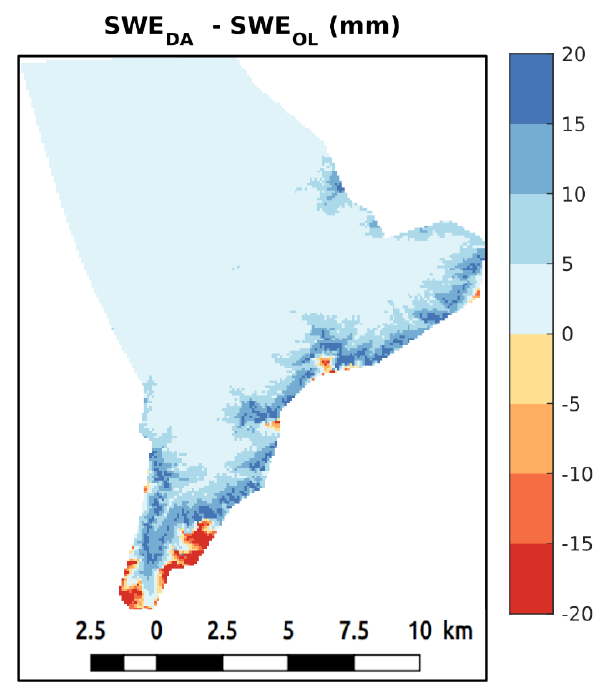
Figure 14. Map of the differences between the mean SWE from simulations with data assimilation (SWE DA ) and open loop (SWE OL ). The mean SWE was computed over the entire study